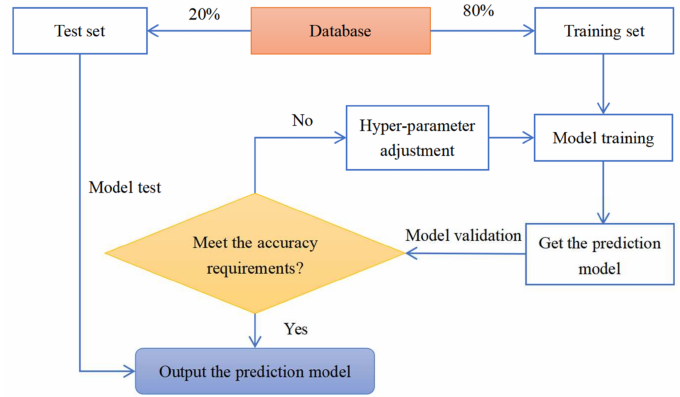
Figure 3. Flowchart for implementation of machine learning